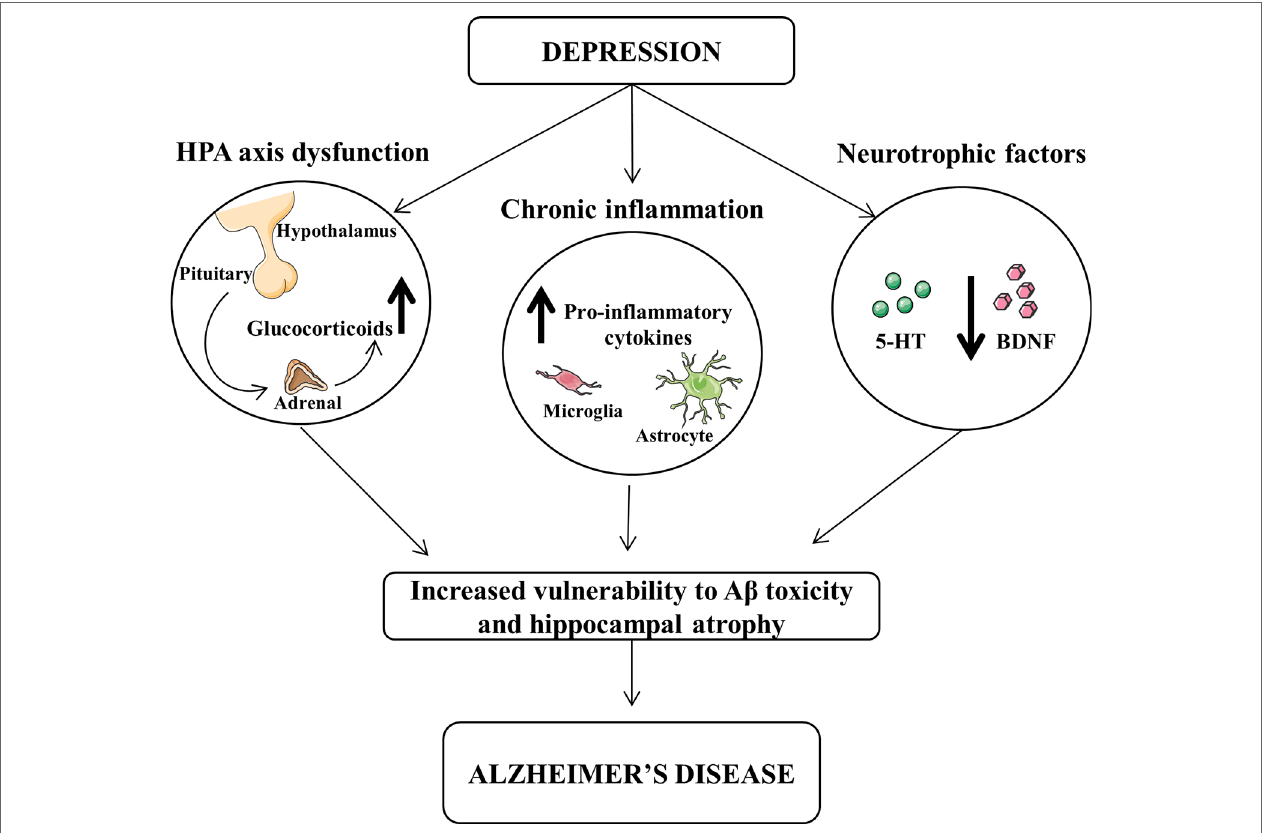
FIGURE 1 | Dysfunction of hypothalamic-pituitary-adrenal (HPA) and decrease of neurotrophic factors and chronic inflammation exert a central role in the pathophysiology of both depression and Alzheimer’s disease (AD). The increased levels of glucocorticoids and pro-inflammatory cytokines, as well as the reduced levels of brain-derived neurotrophic factor (BDNF) and serotonin (5-HT) may lead to an increased vulnerability of β -amyloid toxicity and hippocampal atrophy, thus favoring the progression from depression to